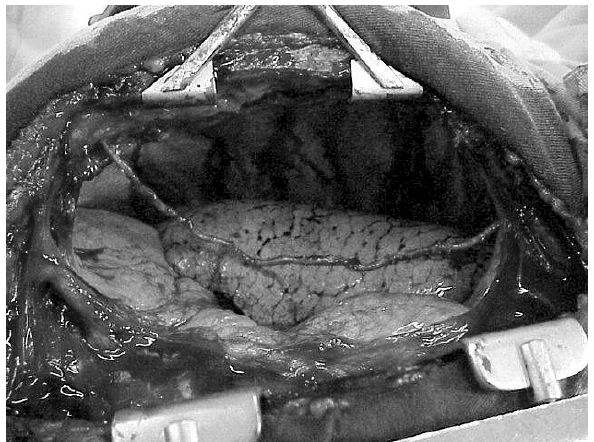
Fig.4 - Aspecto final da artéria torácica interna